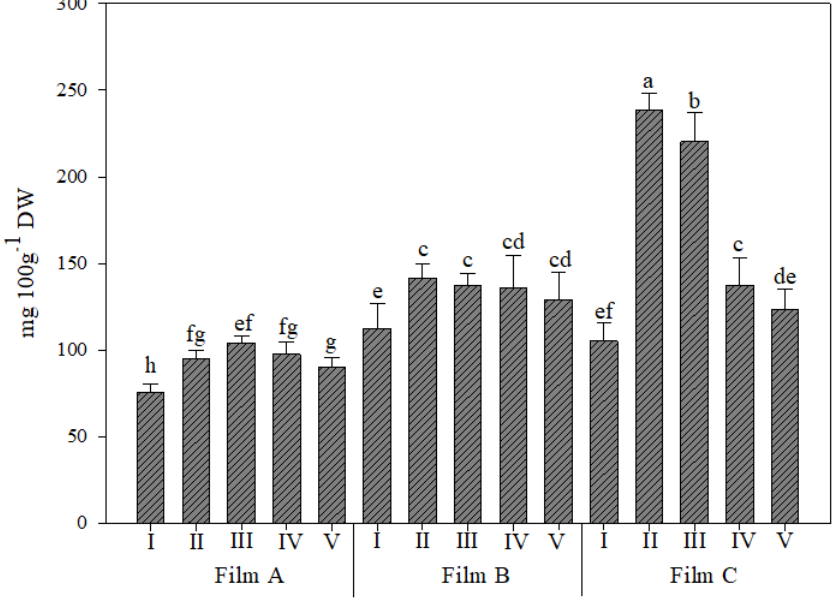
Figure 4. Carotenoid content (mg/100 g of dry weight D.W.) in wild rocket leaves as affected by interaction between greenhouse cover film (Film A: diffused light film; Film B: clear film; Film C: diffused light film with UV-B window) and UV-B applications (I: not treated with UV-B; II: treated with UV-B for 45 s; III: treated with UV-B for 150 s; IV: treated with UV-B for 330 s; V: treated with UV-B for 660 s). Vertical bars indicate standard error; different letters indicate significant differences according to Tukey’s test ( p ≤